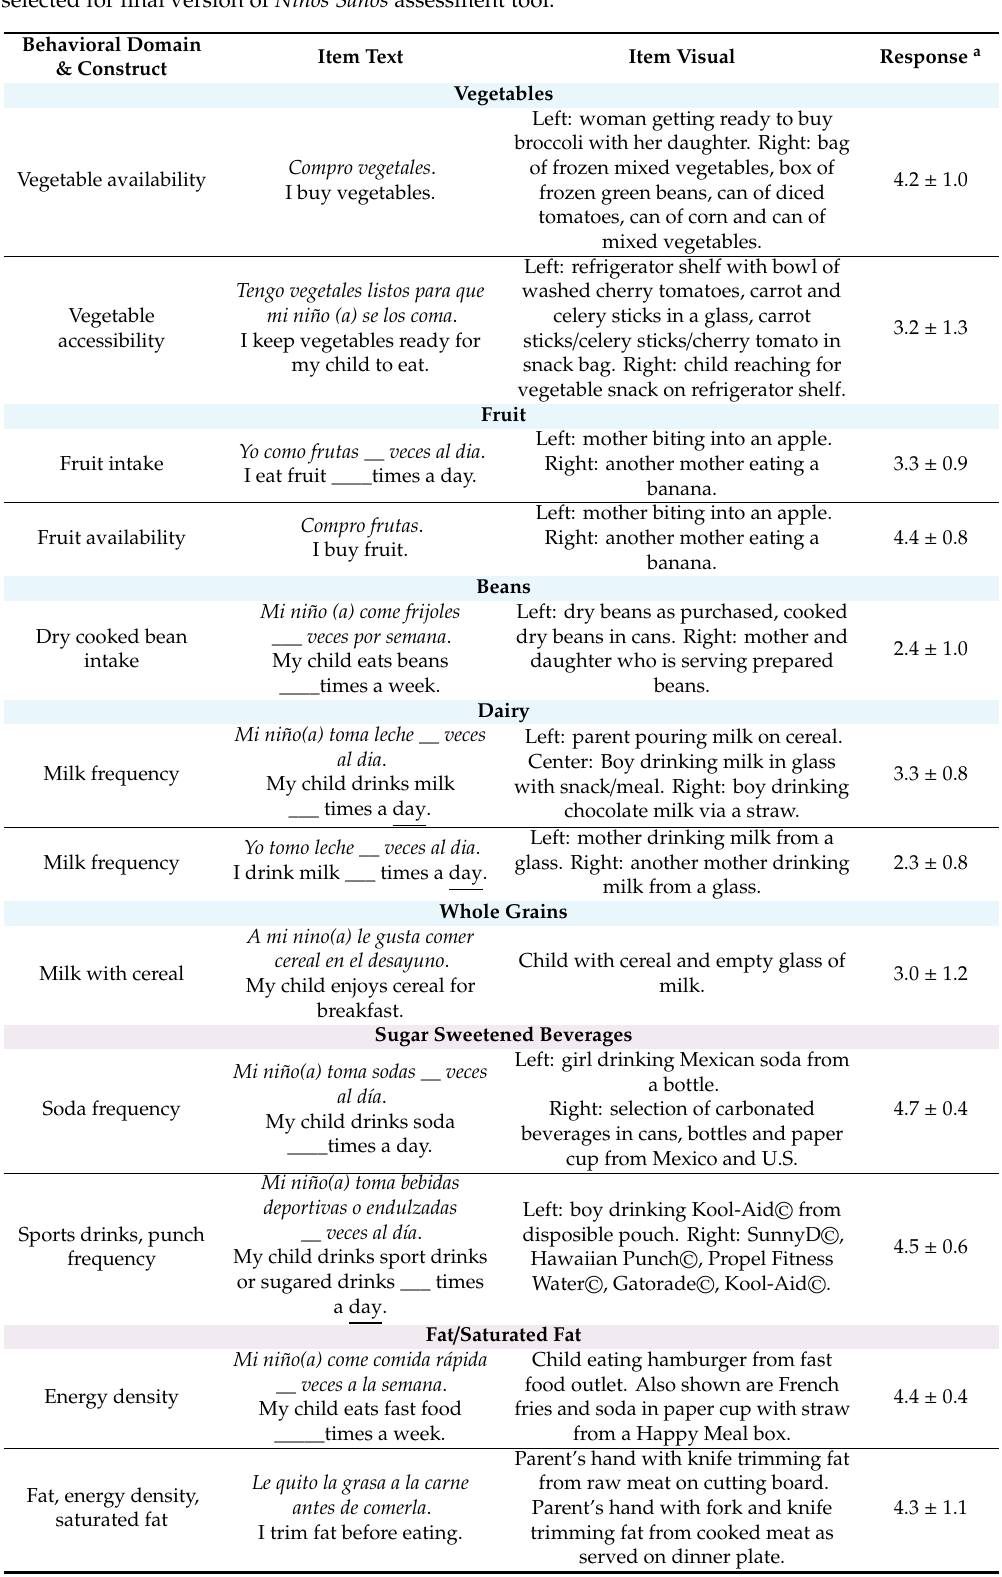
Table 3. Behavioral domain and construct, item text, item visual content and means ± SD for 18 items selected for final version of Niños Sanos assessment